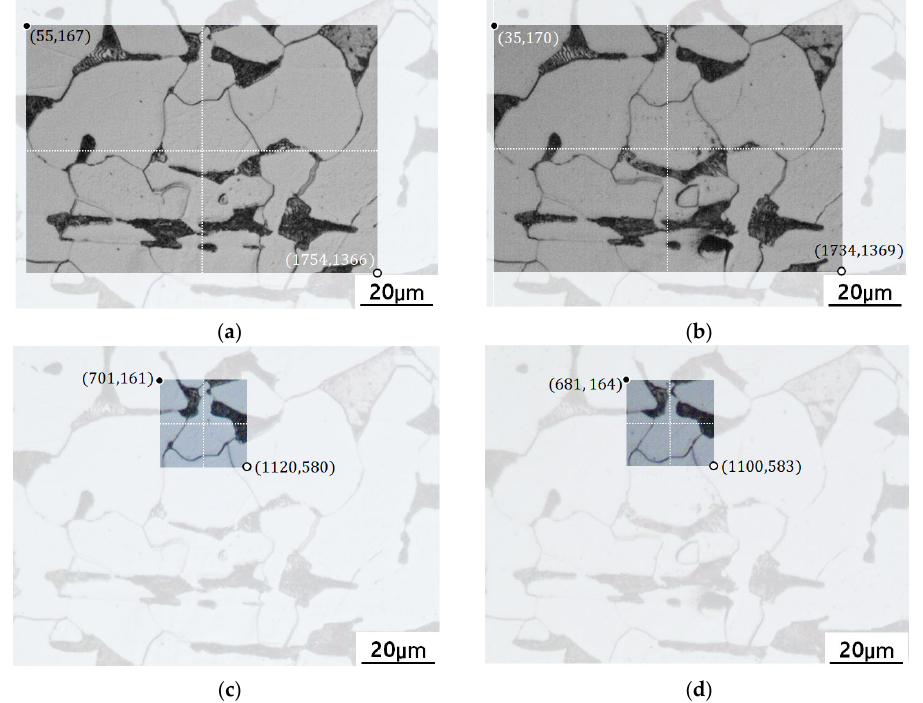
Figure 4. Microscopic photographs with local positioning in a certain area. ( a ) 17th layer, (55,167) ⦣ (1754,1368); ( b ) 18th layer, (35,170) ⦣ (1734,1369); ( c ) 17th layer, (701,161) ⦣ (1120,560); and ( d ) 18th layer, (681,164) ⦣ (1100,583).